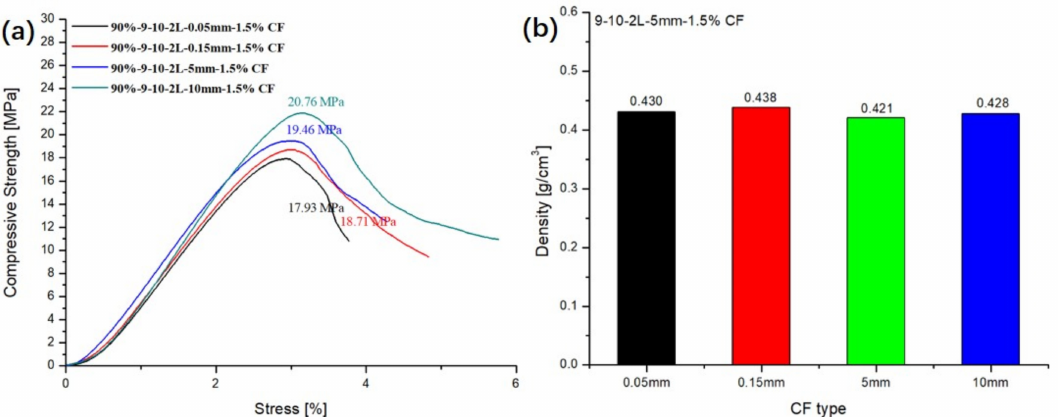
Figure 13. Influence of the length of CF in CFR-EP: ( a ) compressive strength and ( b )